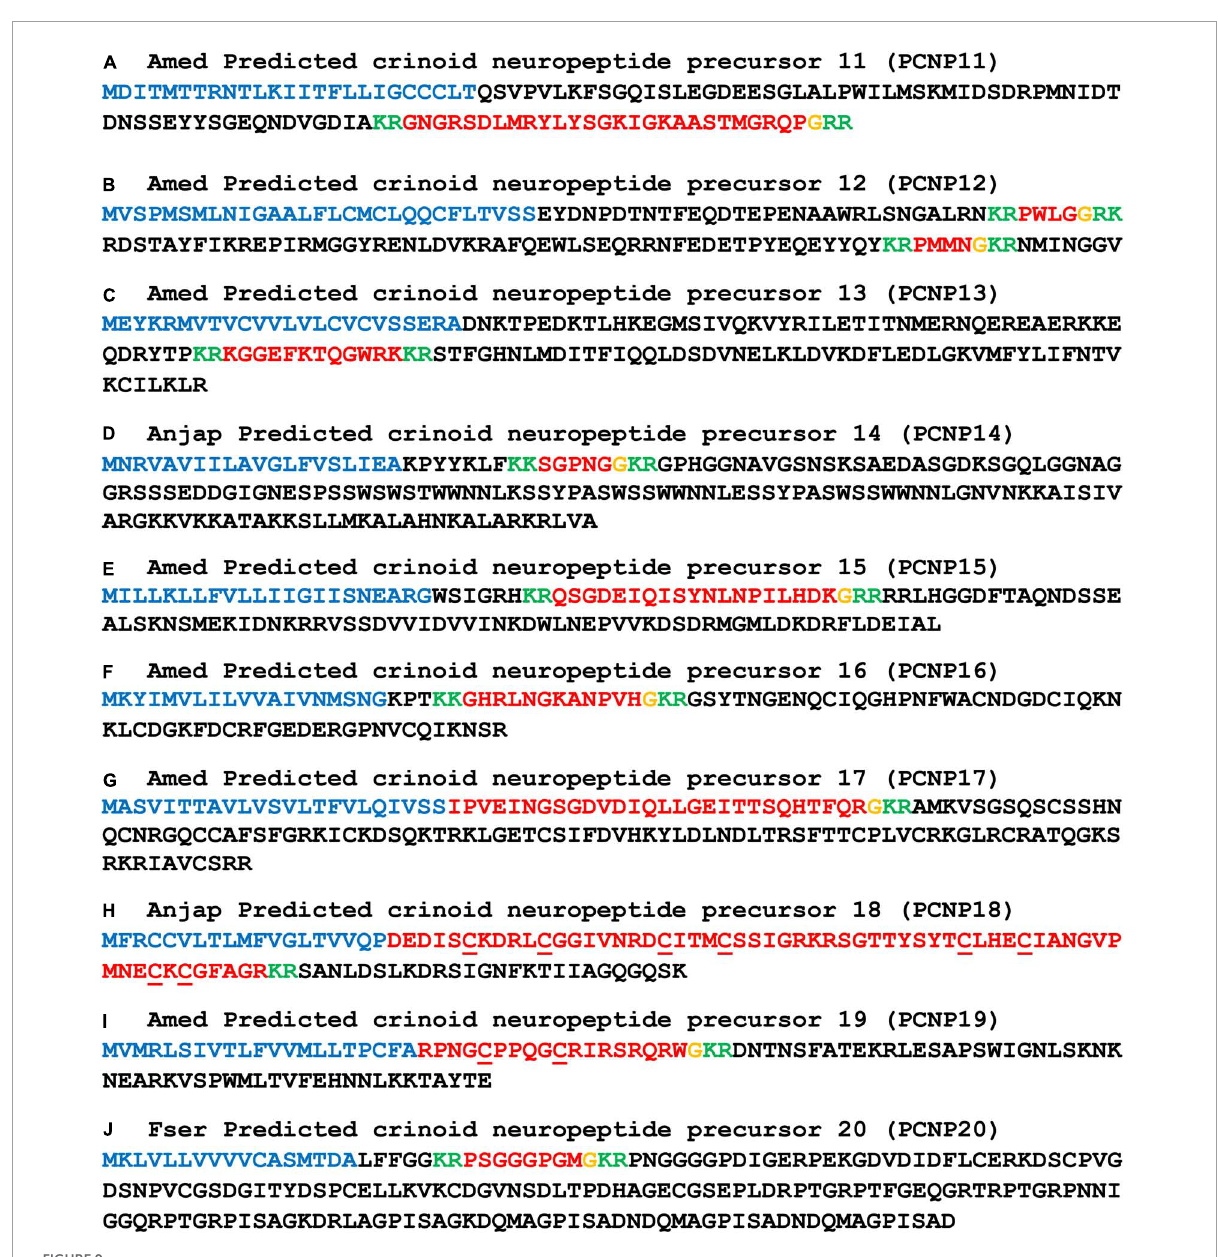
FIGURE9 Other predicted crinoid neuropeptide precursors (PCNP11-20). Neuropeptide precursor sequences from Antedon mediterranea (Amed) are shown, with the exception of those precursors that were partially or not identified in this species and where sequences from Anneissia japonica (Anjap) or Florometra serratissima (Fser) are shown. The predicted signal peptide is shown in blue, predicted monobasic/dibasic cleavage sites are shown in green and predicted neuropeptides are shown in red, but with C-terminal glycine residues that are potential substrates for post-translational amidation shown in orange. The DNA sequences of transcripts encoding these precursors are shown in Supplementary File 2